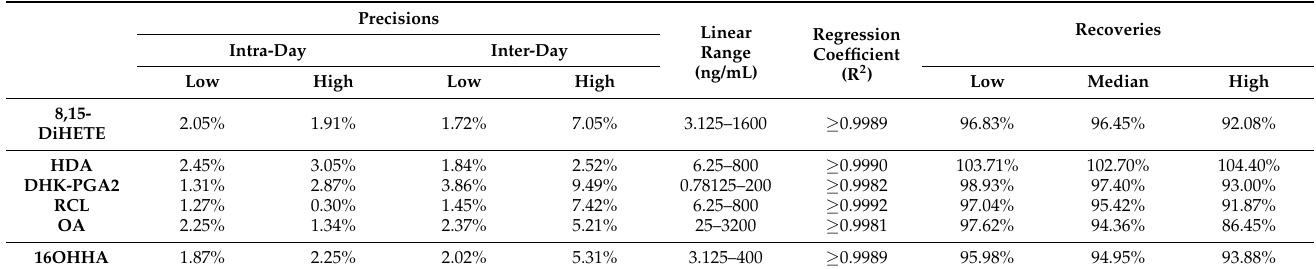
Table 2. The results of methodology validation for the quantification of serum.8,15-DiHETE, HDA, DHK-PGA2, RCL, OA, and 16OHHA.